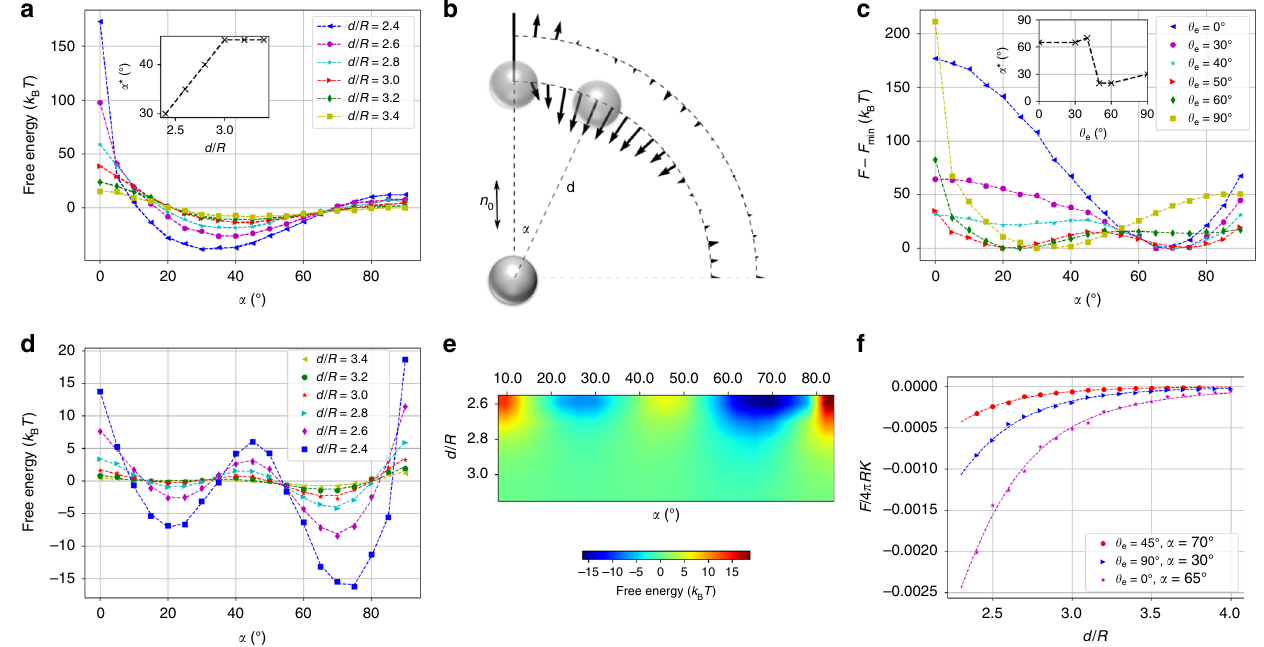
Fig. 2 Angular and radial dependence of colloidal interactions. a Free energy as a function of α for different inter-particle separations d / R for θ e = 90° for two particles ( R = 200 nm) con fi ned in a uniform LC channel ( h = 3.6 μ m). The inset plot shows the dependence of α * on the colloidal separation d . b Vector fi eld of forces between two colloidal particles for d / R = 2.6 and 3.2, derived from the spatial gradient of free energy. The far- fi eld director is denoted by n 0 . c Evolution of free energy as a function of α with different θ e ( d / R = 2.4). The inset plot shows the dependence of α * on colloidal separation d . d , e Evolution of free energy as a function of α for different d / R with θ = 45°. f Dependence of attraction on d / R for particles with θ = 45°, 90°, and e e θ = 0°, along α = 70°, 30°, and 65°. The dashed line is a least-squares fi t of colloidal pair-interactions. The coef fi cients are ( b = − 0.0088, b = − 0.0144, e 2 4 b = − 0.0004), ( b = − 0.0496, b = − 0.0089, b = − 0.0005), ( b = 0.1001, b = − 0.0105, b = 0.0009) for colloids with θ = 45°, 90°, and θ = 6 2 4 6 2 4 6 e e